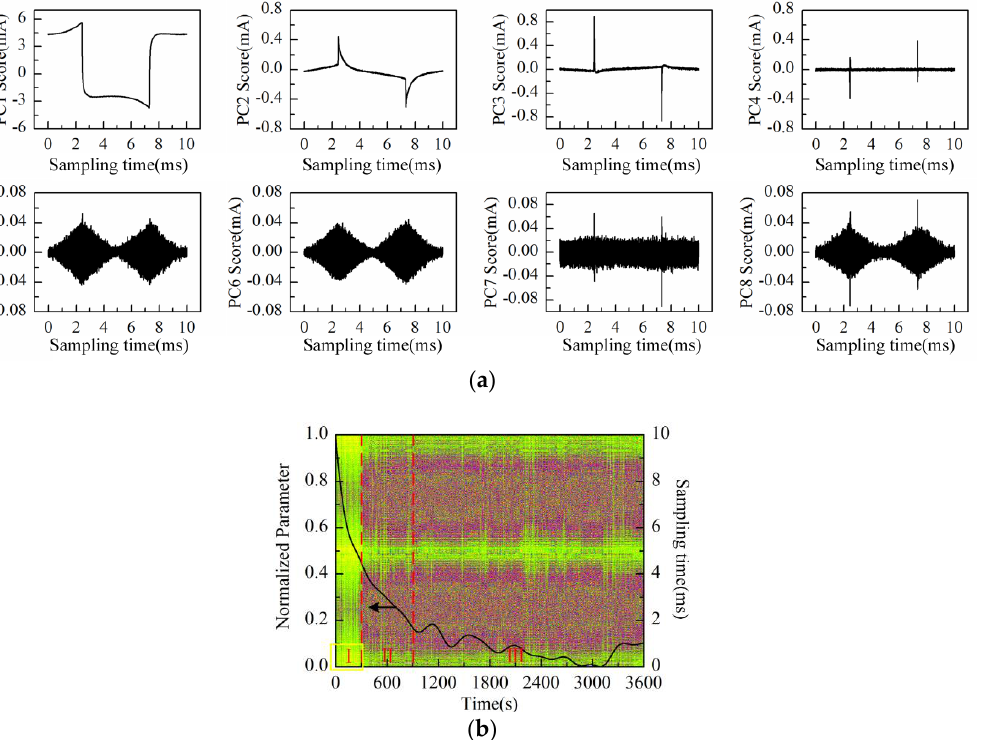
Figure 11. Measurement results of Mercaptopropionic Acid (MPA) solution conducted with Au-IDT: ( a ) PC1–PC8 scores plot; ( b ) PC1 loading curve (after SSA) and the reconstructed noise image.